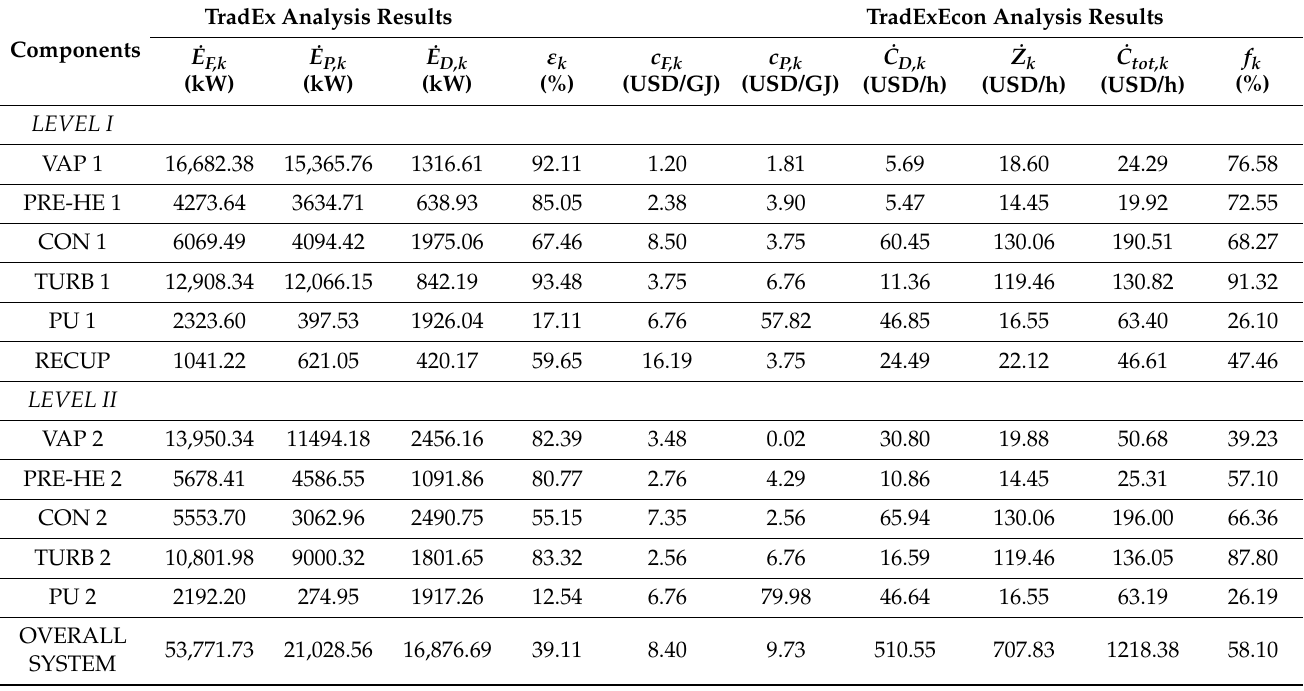
Table 4. The outlined findings of the TradEx and TradExEcon analyses for all the components in the Sinem